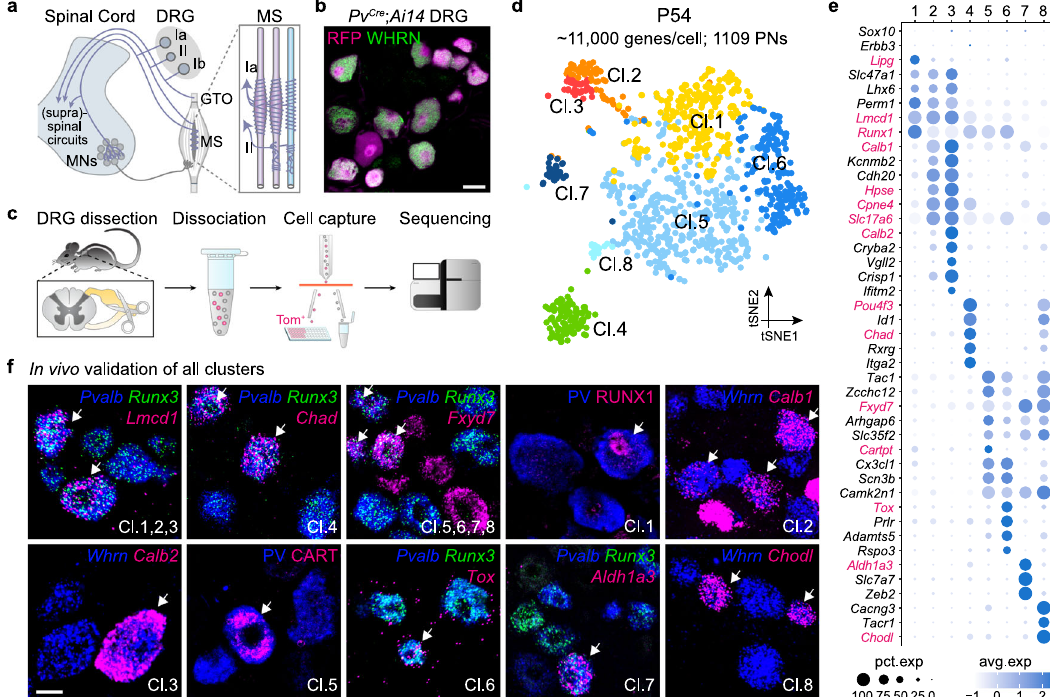
Fig. 1 Deep scRNAseq reveals large heterogeneity among adult PNs. a Schematic depiction of the central and peripheral innervation patterns of the three major PN types in the adult. b Brachial DRG section of P40 PV Cre ; Ai14 mouse stained for PN marker WHRN. Scale bar: 20 µ m. c Schematic illustration of the work fl ow for scRNAseq of P54 PNs. d Adult PNs single-cell transcriptomes visualized with t-distributed stochastic neighbor embedding (tSNE), color- coded for the eight molecularly de fi ned clusters. e Examples of marker genes expression in each cluster. The size of the circle re fl ects the proportion of the